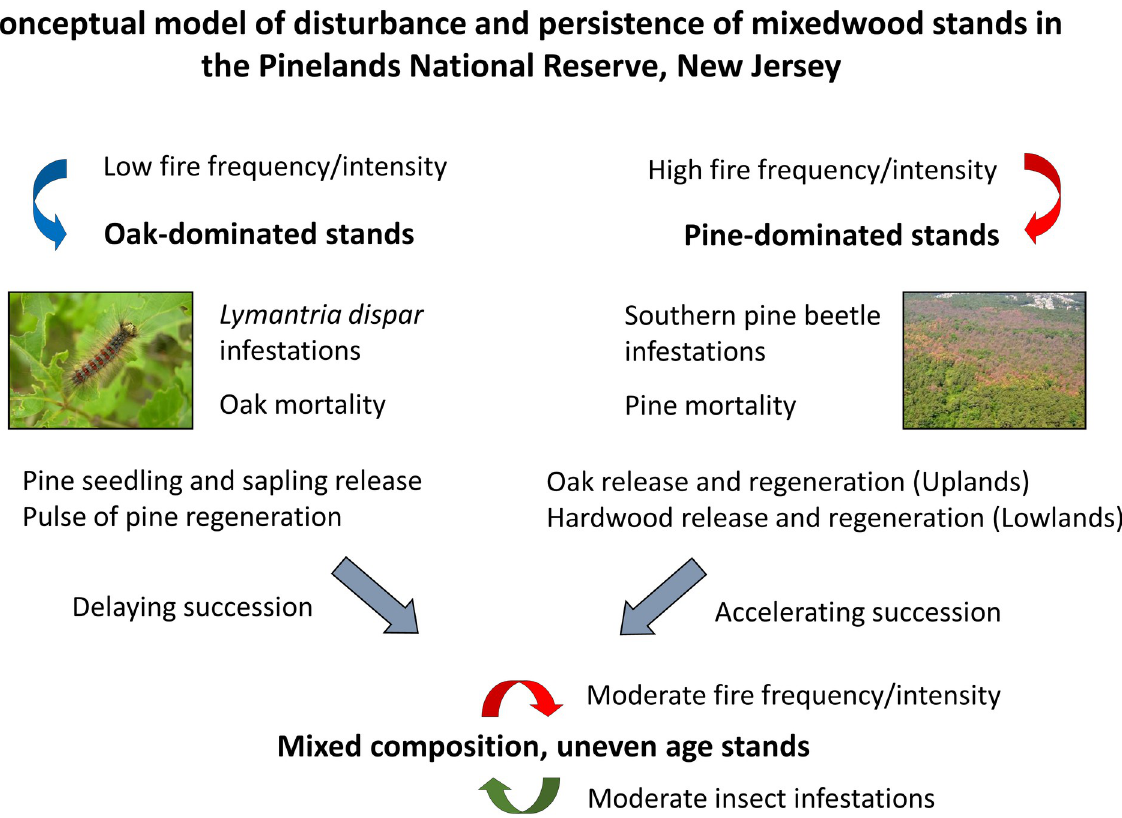
Fig 1. A conceptual model of forest composition in intermediate age oak- and pine- dominated stands in the New Jersey Pinelands National Reserve. In oak-dominated stands, repeated defoliation by L . dispar and differential mortality of oak trees and saplings facilitates the regeneration and release of pine seedlings and saplings. In pine-dominated stands, southern pine beetle causes significant pine tree mortality, while oaks in upland stands and other hardwoods in lowland stands are unaffected. These infestations are favoring the formation of uneven- aged, oak-pine mixedwoods in upland stands, and uneven-aged hardwood-pine mixedwoods in lowland